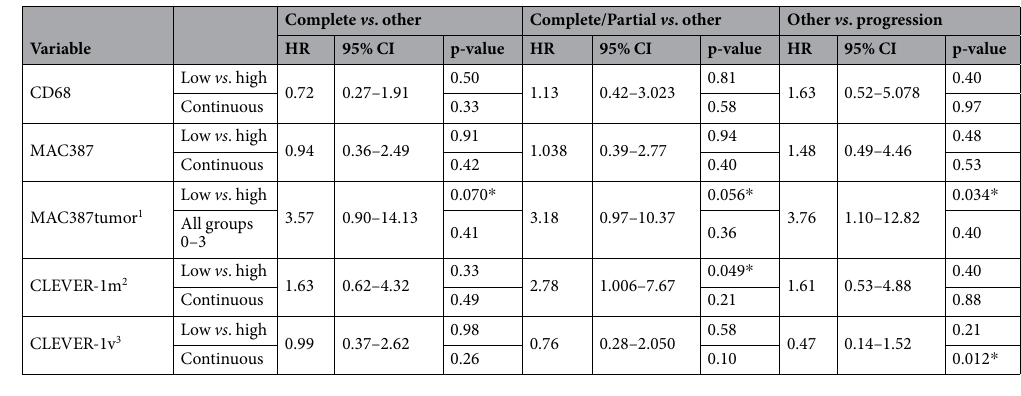
Table 3. Associations between markers and chemotherapy response. Regression analyses were used to evaluate the association between the chemotherapy response and marker groups dichotomized according to the mean value. Mann-Whitney U test was used to evaluate the association between the continuous variables and chemotherapy response. Pearson Chi-square/Fisher’s exact test was used to evaluate the association between MAC387 + tumor cells and chemotherapy response. 1 MAC387 positive tumor cells; low (score 0–2), high (score 3). 2 CLEVER-1 positive macrophages. 3 CLEVER-1 positive vessels. * Significant